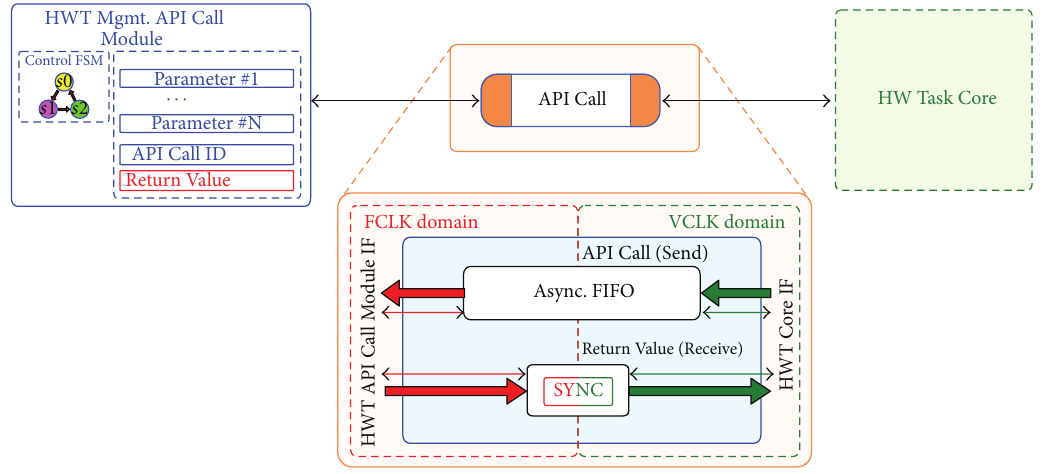
Figure 10: Management API Call